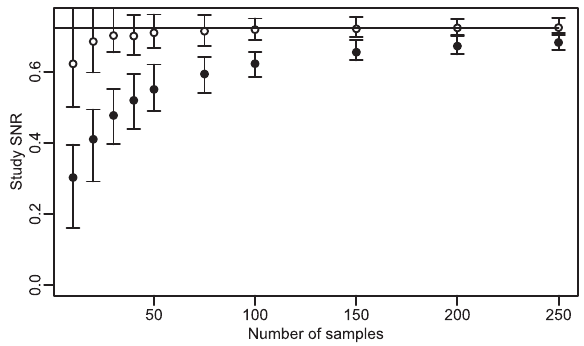
Figure 4. SNR in function of the number of samples: effect of disattenuation. Subsets of a very large dataset (expO) were created by randomly selecting a number of samples. The study SNRs of those subsets are shown in function of their size, with disattenuation ( 0 ) or without ( . ). The error bars are the 95% confidence intervals determined by resampling. The horizontal line is the SNR of the whole data